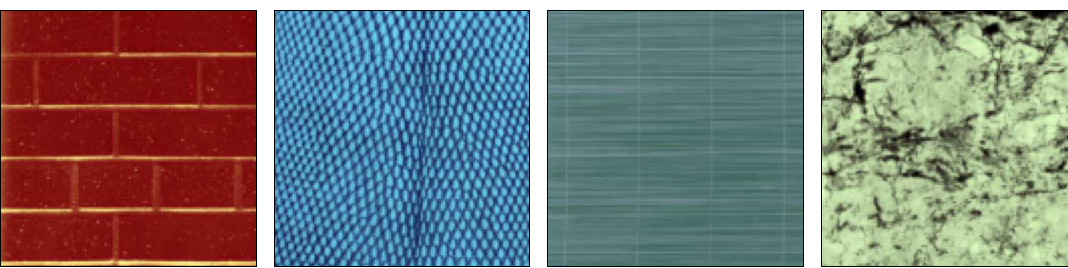
Figure 2. Texture images from the Prague Texture Segmentation Datagenerator and Benchmark [70].